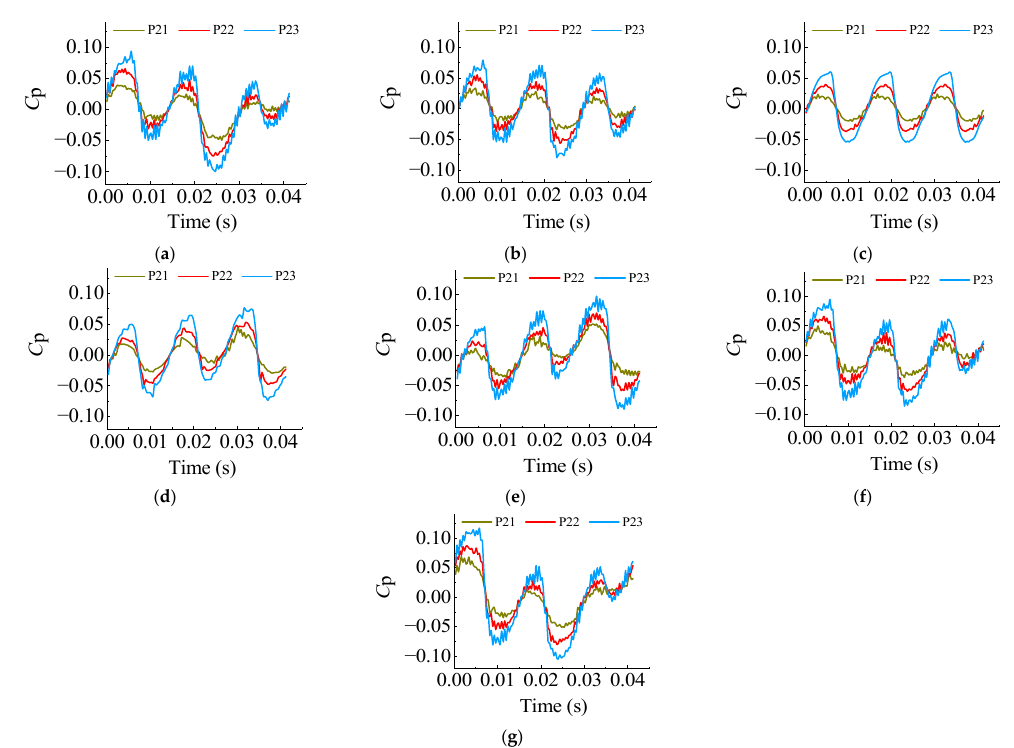
Figure 14. Time-domain diagrams of the pressure fluctuations at the impeller outlet: ( a ) Design Scheme I; ( b ) Design Scheme II; ( c ) Design Scheme III; ( d ) Design Scheme IV; ( e ) Design Scheme V; ( f ) Design Scheme VI; and ( g ) Design Scheme VII. Table 4. Pulsation amplitudes at P2.